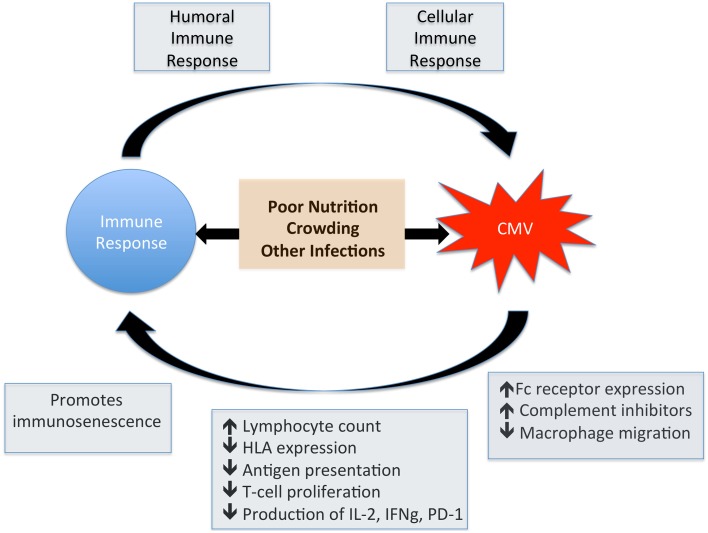
Impact of CMV on the immune system. This figure shows the potential for bi-directional interplay between CMV and the immune response. CMV induces a robust humoral and cellular immune response whilst at the same time has a direct influence on normal immune function. Factors such as poor nutrition and low weight, crowded living conditions and other herpes virus coinfections also have an impact on immune function and are associated with increased CMV seroprevalence.